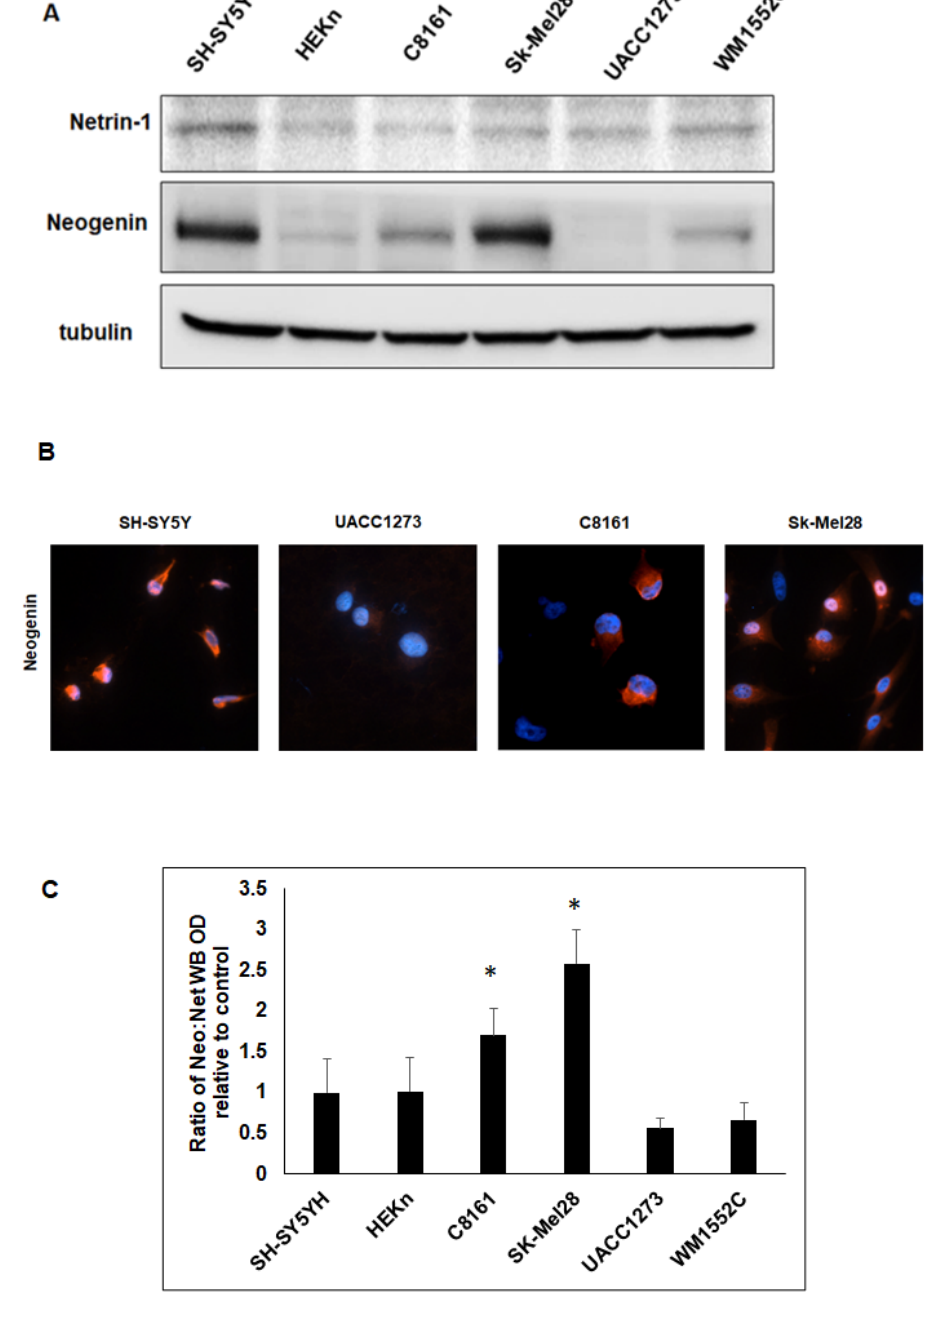
Figure 1. Expression of Netrin-1 and Neogenin in human melanoma cells. ( A ) Western blot results show different levels of Netrin-1 and Neogenin expression in human melanoma cell lines. The human neuroblastoma cell line SH-SY5Y and the normal human epidermal keratinocyte cell line HEKn were used as positive-expressing and poorly expressing controls for cellular expression of Netrin- 1, respectively. ( B ) Results from immunofluorescence (IF) staining shows more intense expression of Neogenin in the aggressive melanoma cell lines C8161 and Sk-Mel28 compared to the poorly